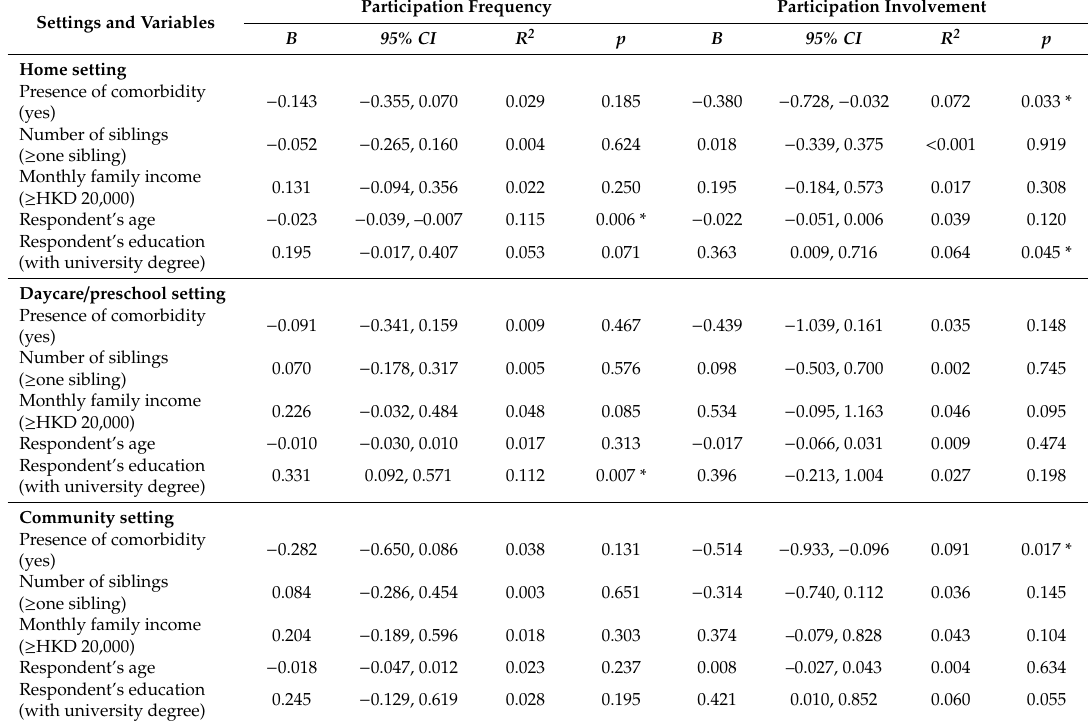
Table 3. Univariate associations between children’s participation and demographical variables in the study.